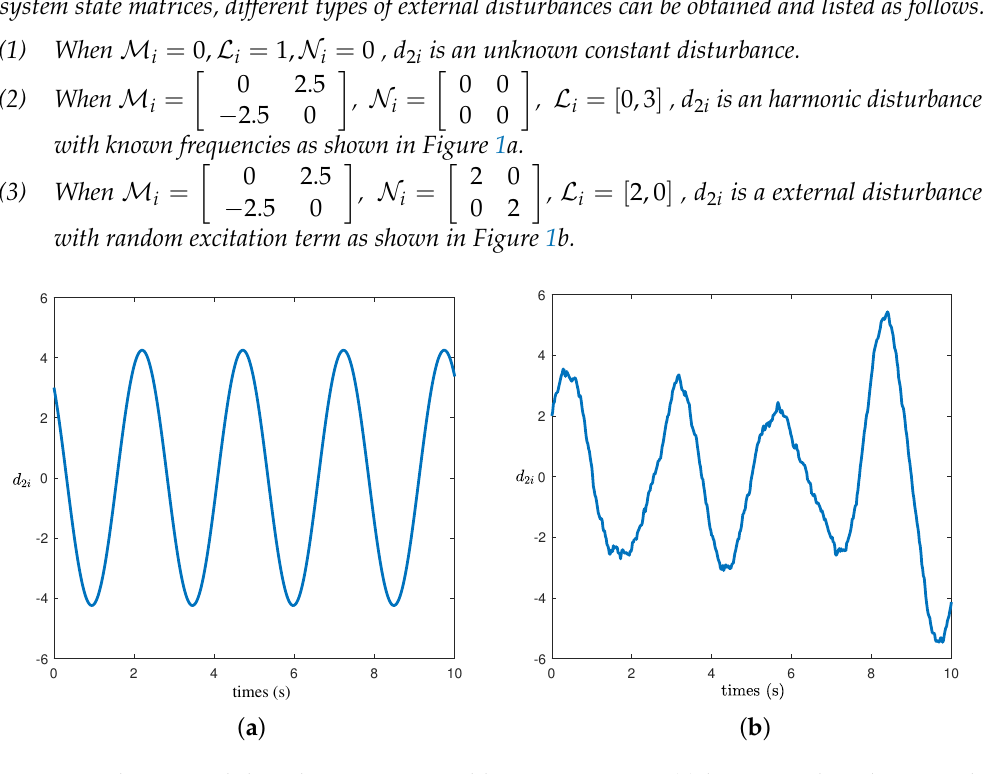
Figure 1. The external disturbances generated by an exosystem: ( a ) harmonic disturbance with known frequencies; ( b ) external disturbance with random